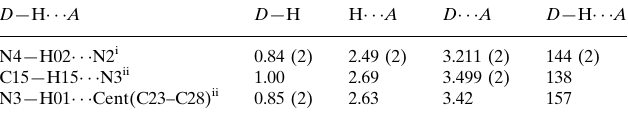
Hydrogen-bond geometry (A˚ , (cid:1)